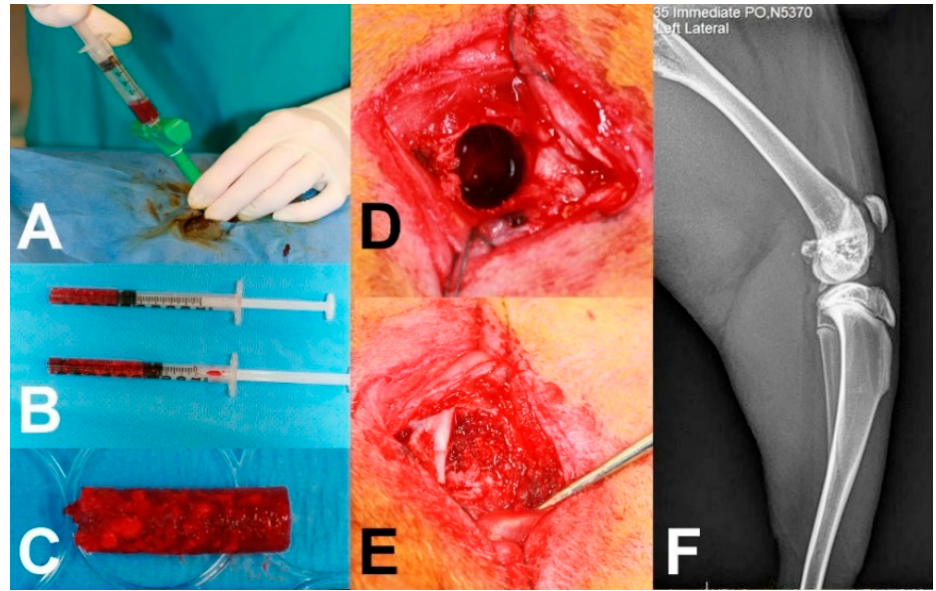
Figure 2. At the onset of surgery, bone marrow aspirate was drawn from the iliac crest of each rabbit ( A ) and mixed with porous or non-porous hydroxyapatite granule at 1:1 ratio by volume in a 1 mL syringe ( B ) to form implantable cylinders ( C ). 6 mm × 8 mm (diameter × length) defects were created bilaterally in the femoral chondyles ( D ) and packed with the graft materials ( E ), which were observed radiographically ( F ).